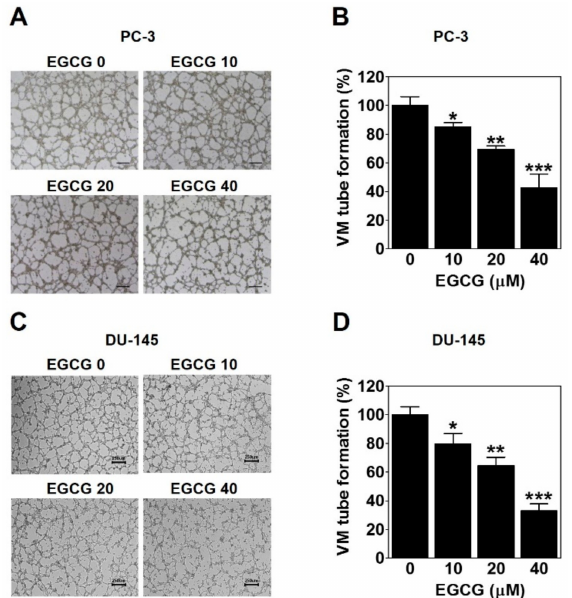
Figure 3. EGCG inhibits the vasculogenic mimicry (VM) of PC-3 and DU-145 cells. A cell suspension with EGCG was seeded into matrigel-coated wells and incubated for 24 h. ( A , C ) VM structures were photographed at 40 × magnification. Scale bar = 250 µ m. ( B , D ) The number of VM structures was quantified. Data are expressed as means ± SD. Results were statistically calculated by Student’s t -test. * p < 0.05, ** p < 0.01, and *** p < 0.001 vs. untreated